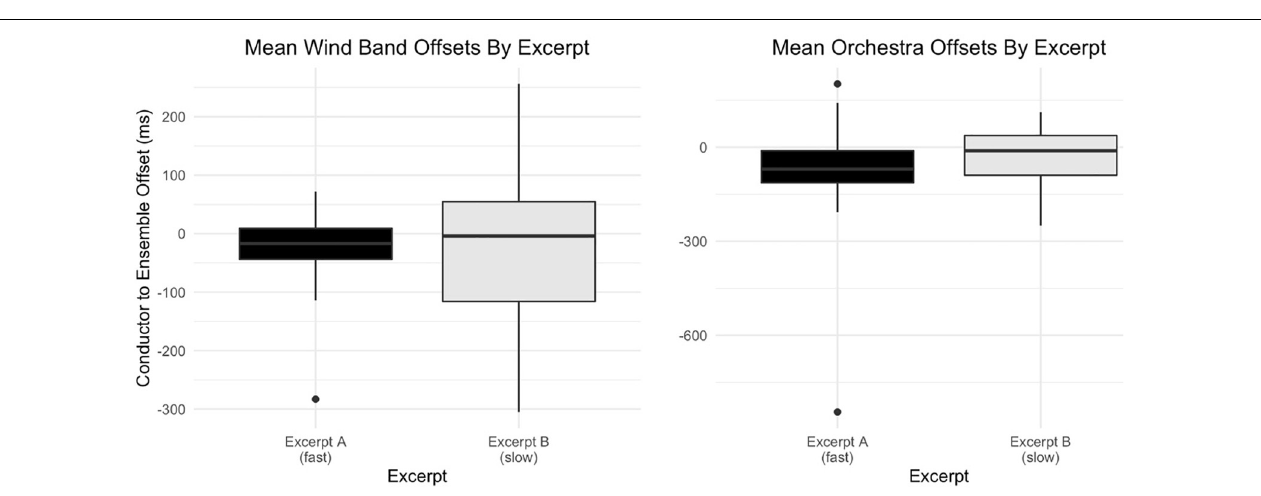
scholarship. This exploratory study suggests that observed offset is not a static property of ensemble function but is in fact a flexible property of internal temporal interaction that indicates a